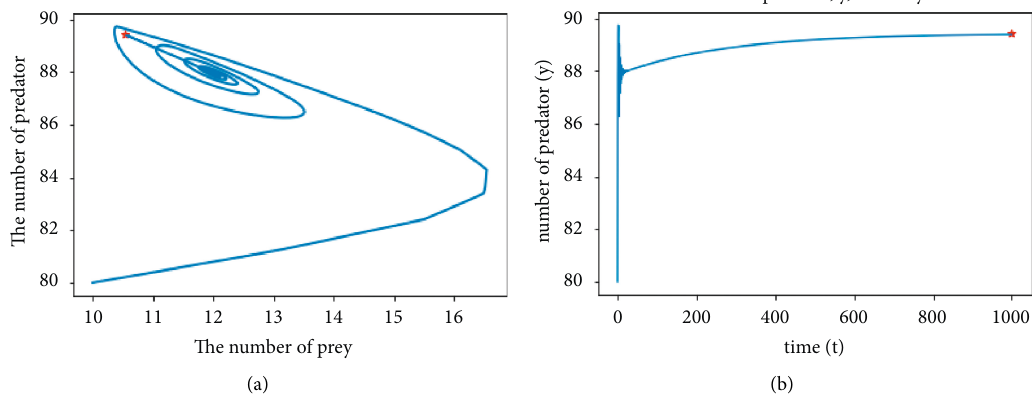
Figure 4: Delay case, τ � 2. (a) The phase portrait; (b) the number of predators with short delay.